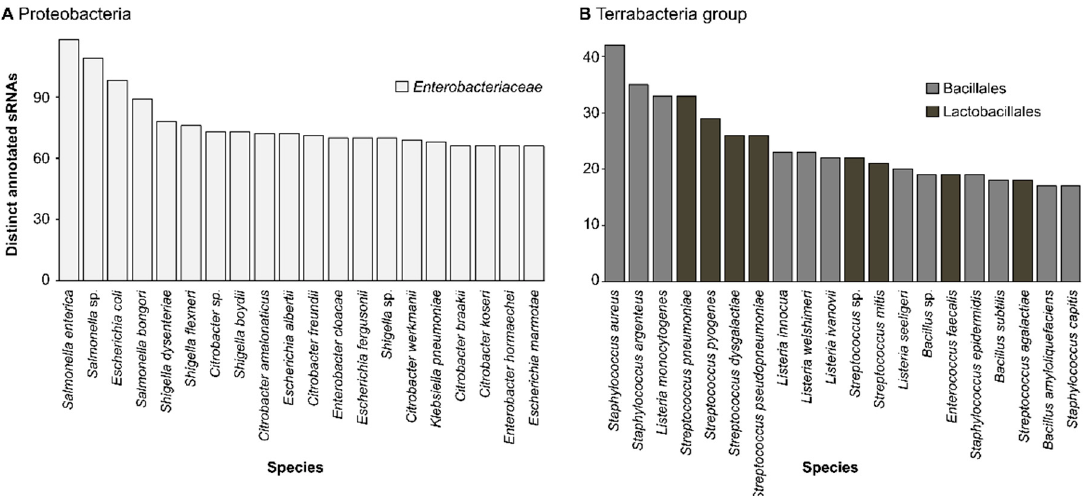
Figure 2. Top 20 bacterial species with the highest number of distinct annotated sRNAs in ( A ) Pro- teobacteria and in ( B ) bacteria from the Terrabacteria group. Species denoted with “sp.” represent instances where only the genus of the bacteria was noted. It can be observed that in ( A ), all species are from the same family, Enterobacteriaceae . In ( B ), species from different orders are emphasized by their own color. The number of distinct sRNAs considers all strains for each species. Only sRNAs with an E-value lower than 0.0005 were considered.